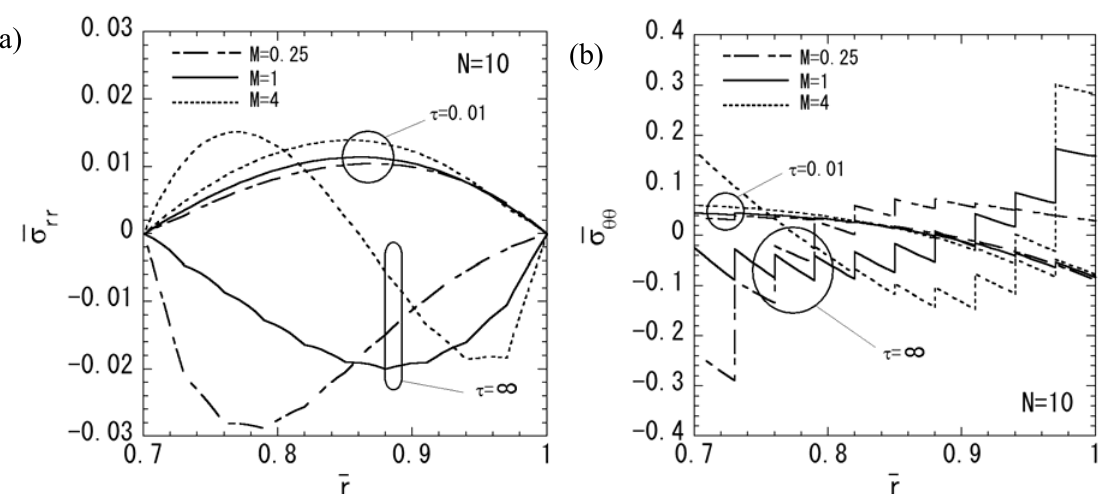
Figure 6. Variation of the thermal stresses ( 10 = N ): ( a ) normal stress